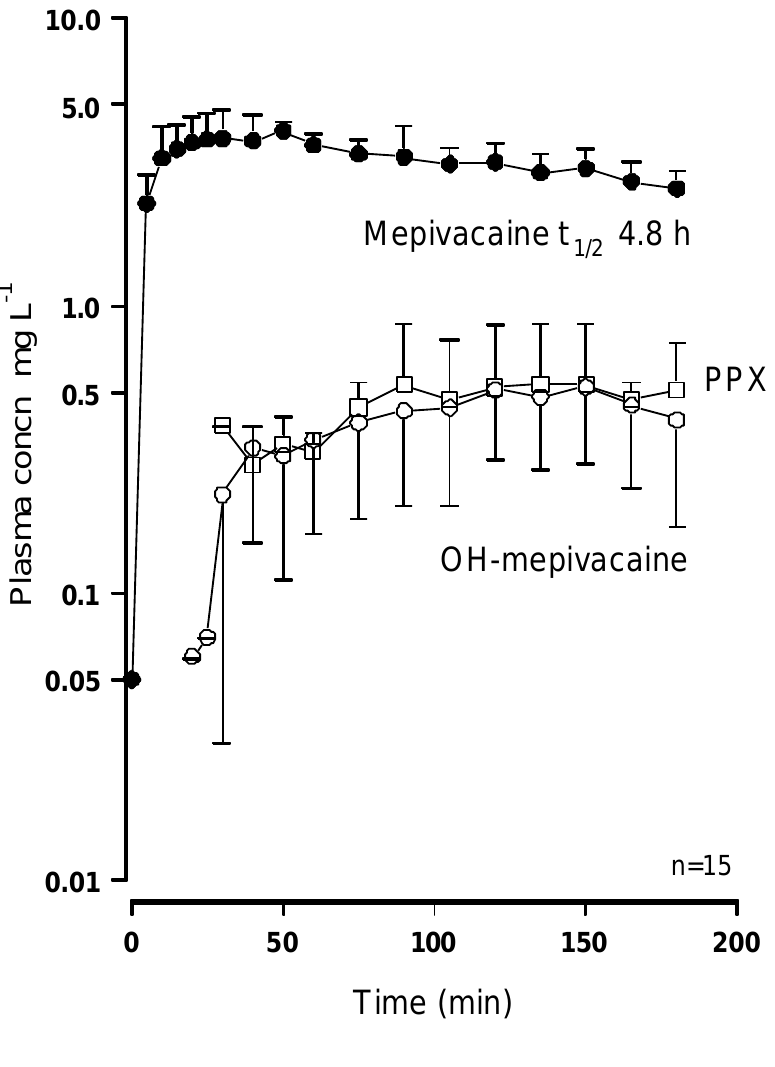
FIGURE 3 . Mean plasma concentration–time curves of mepivacaine (mg l –1 ± s.d.), and its metabolites 4´- hydroxymepivacaine (4-OH, open dots) and 2,6-pipecoloxylidide (PPX, open squares) after axillary administration of 600 mg mepivacaine (+ 5 mg ml –1 adrenaline) (n =